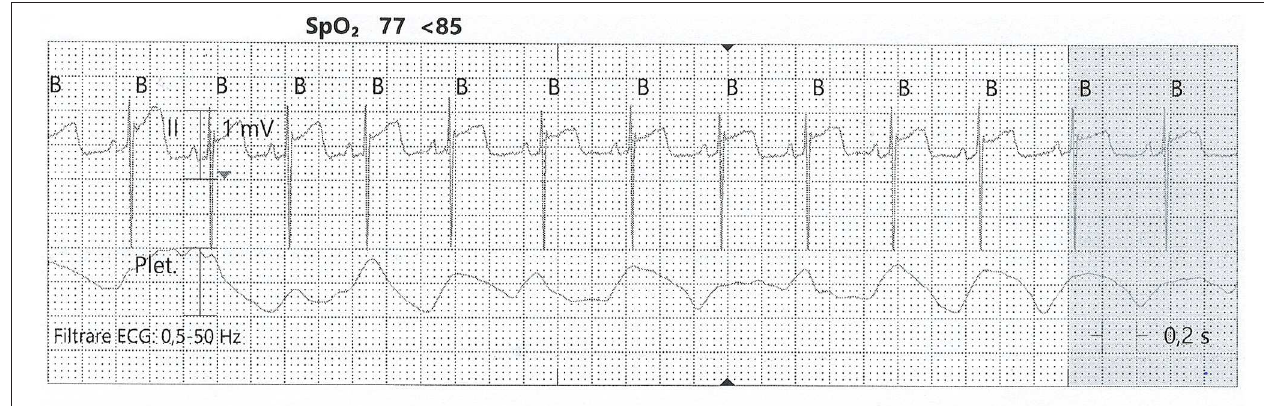
FIGURE 3 | ST-elevation on an ECG tracing from a neonate with PA. SpO 2 , partial pressure of oxygen; Plet, plethysmography (from the collection of Neonatology Department, Filantropia Clinical Hospital, Bucharest, Romania).